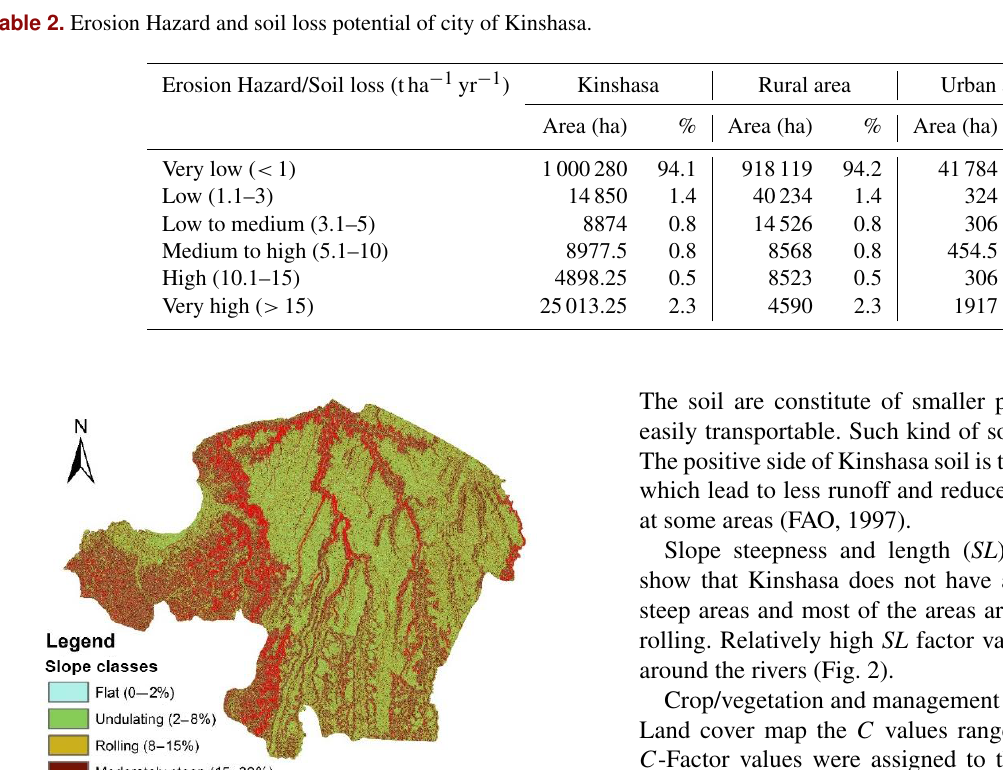
Soil erosion parameters